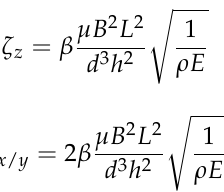
Table 1. Designed dimensions of the